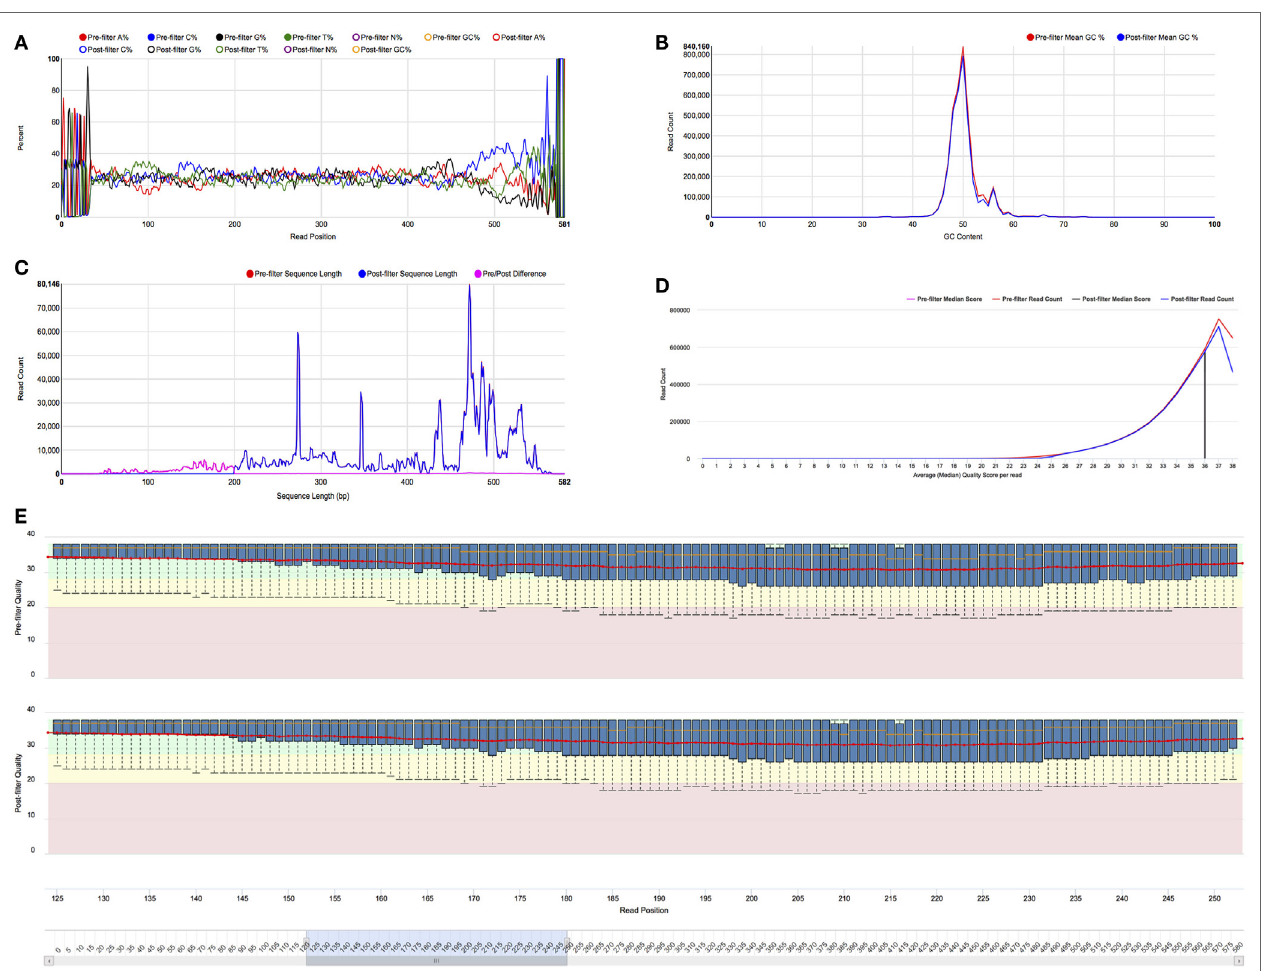
FIguRe 4 | Preprocessing visualizations. All of the charts provide pre- and post-filtering statistics for side-by-side comparison. Full size versions of the figures are provided in Supplementary Material. (A) Nucleotide composition for each read position. Each colored line represents the percentage of a nucleotide or ambiguous base call (N) at each read position. The legend functions as a toggle to set which lines are shown. This figure is currently showing the composition pre-filtering for A, C, G, and T nucleotides. (B) GC content histogram. The graph shows the number of reads along the Y axis and GC percentage along the X axis. The red curve indicates the number for pre-filter reads, and the blue curve represents the number for post-filter reads. (c) Sequence length histogram. The graph shows the number of reads along the Y axis and sequence length along the X axis. The red curve shows the number of sequences of each length for pre-filter reads, the blue curve shows the number for post-filter reads, and the magenta curve shows the pre/post difference. The graph clearly shows that a length filter of 200 was used. (D) Mean quality score histogram. The graph shows the number of reads along the Y axis and the average quality score along the X axis. The red curve shows the number of sequences for pre-filter reads, and the blue curve shows the number for post-filter reads. The magenta and black vertical lines show the median score (36) for the pre- and post-filter reads, respectively. (e) Quality score distribution for each read position. Quality score is shown on the Y axis, and read position is shown on the X axis. At each position, the box-and-whiskers plot shows the median quality score, inter-quartile range, and the 10th and 90th quantiles. The X axis has zoom control, which is set to positions 125–250 in this